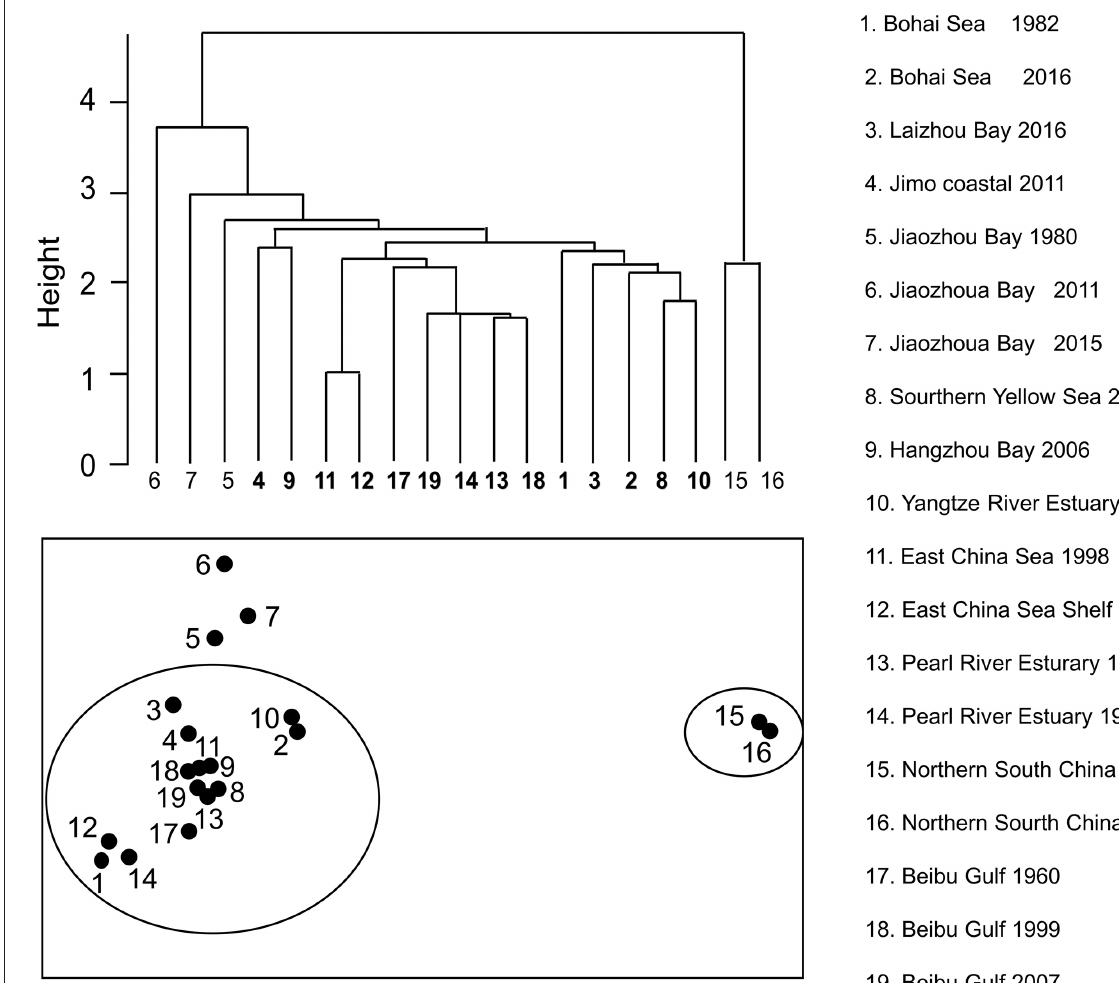
FIGURE 5 | H-clustering and multidimensional scaling (MDS) groups for 19 Ecopath models in China’s coastal